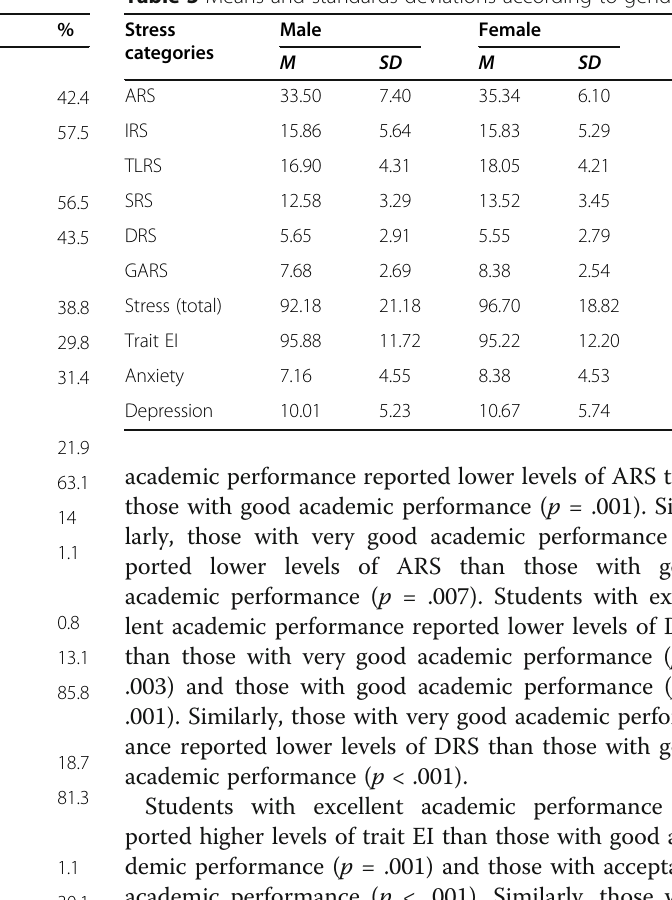
Table 1 Frequency of demographic variables